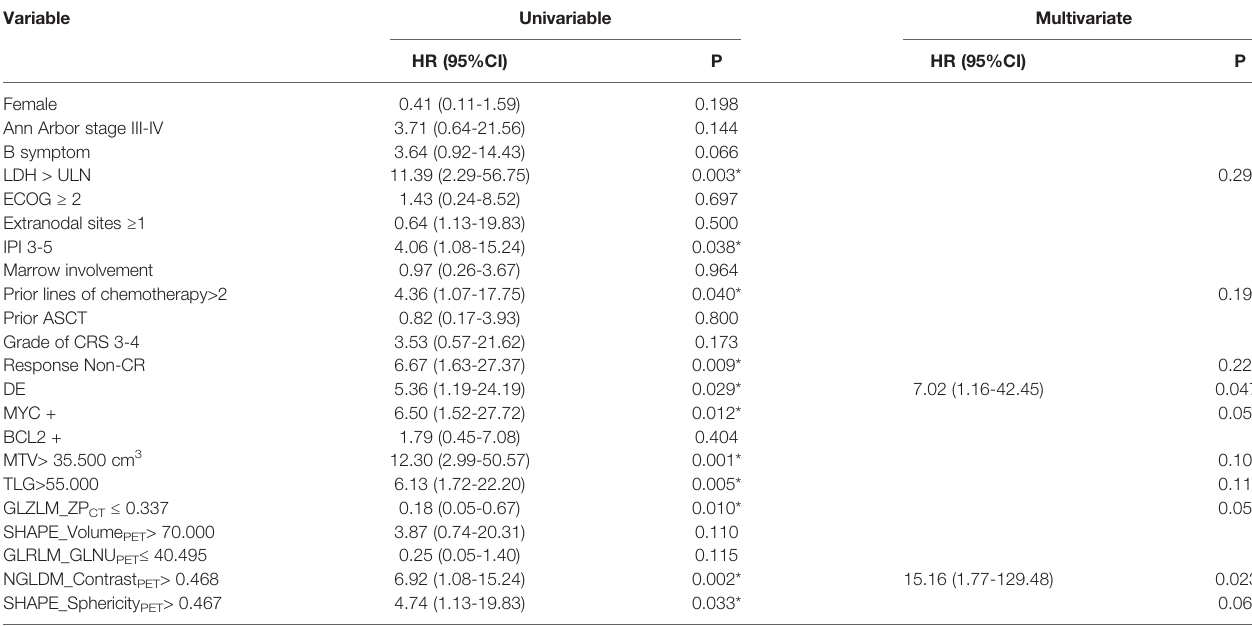
TABLE 3 | Univariable and multivariate analyses of predictive factors for